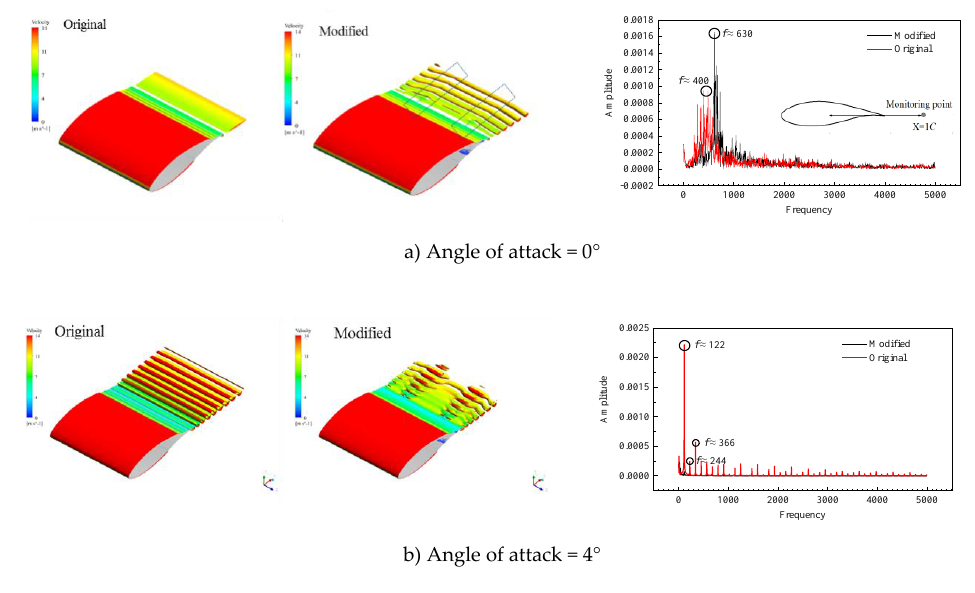
Figure 14. Isosurface of Q and spectrum distribution at monitoring points.